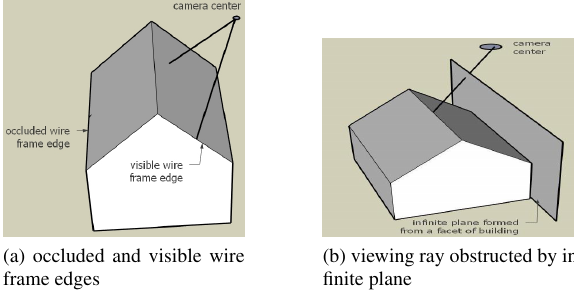
Figure 2: Self-occlusion test